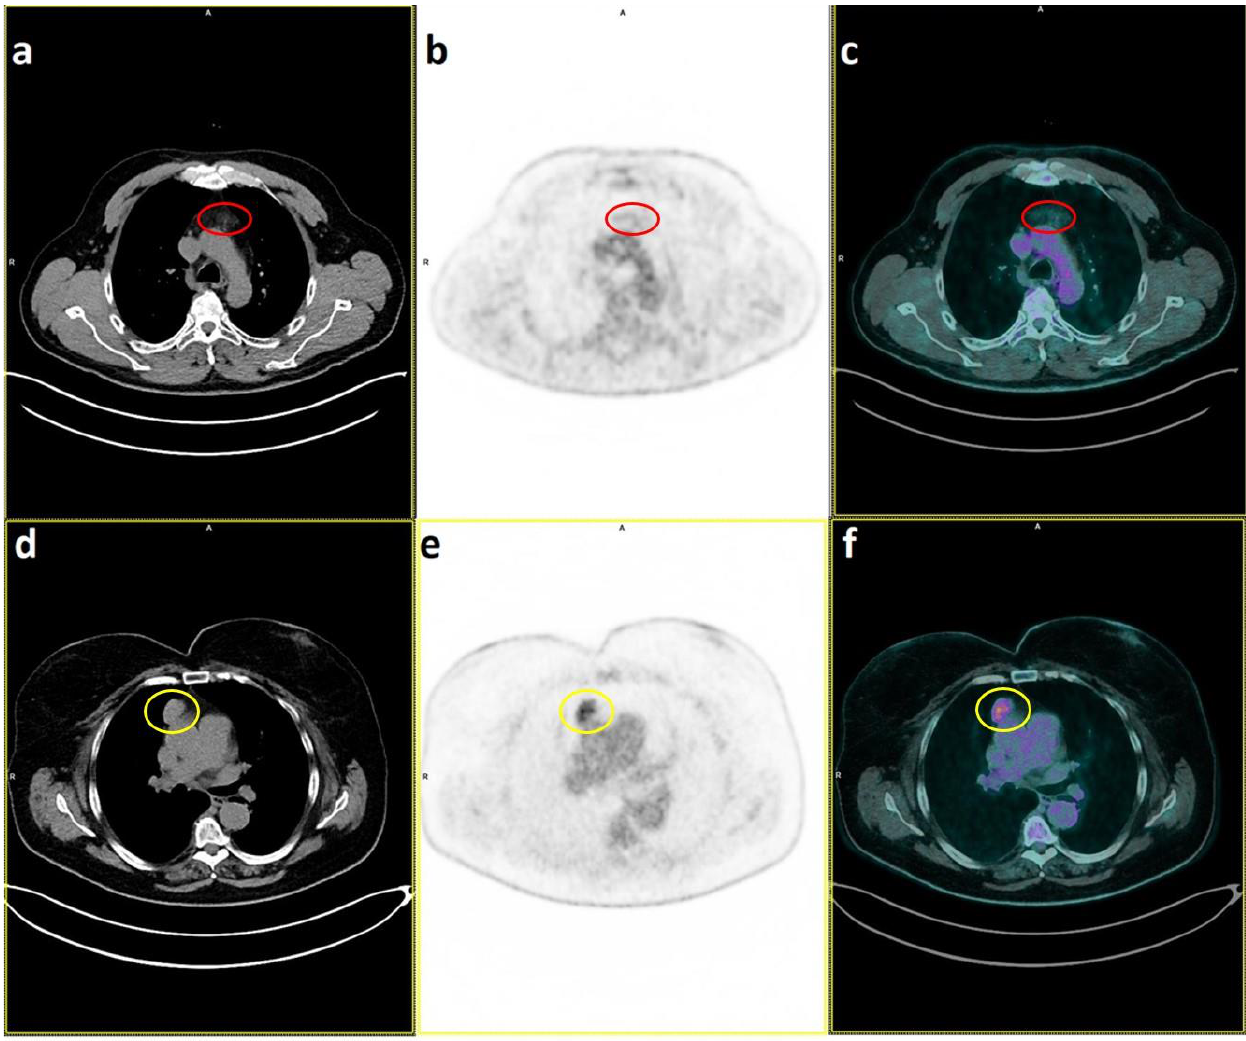
Figure 1. PET CT scan shows absence of uptake in a case of Thymic Hyperplasia (Figure 1 ( a – c ), with red circle) [18] compared with mild focused uptake in an A-Thymoma (Figure 1 ( d – f ), yellow circle) [18] compared with mild focused uptake in an A-Thymoma (( d – f ), yellow circle) circle) [36].